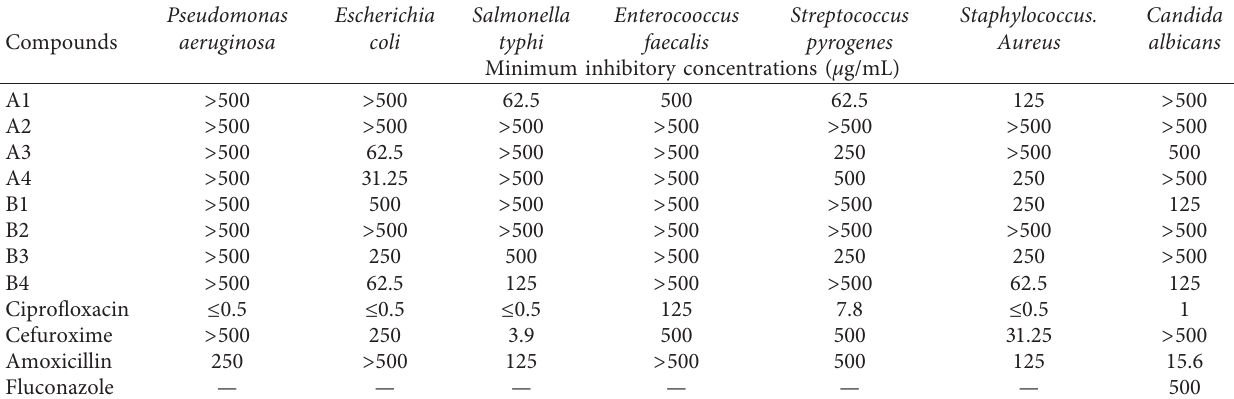
Table 3: Antimicrobial activity of the synthesised azo